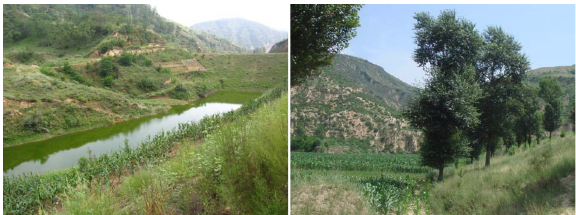
Fig. 1. Sample graphs of check dam (Left: Water body behind a check dam; Right: Farmland formed by a check dam) (Photo: Yafeng Wang and Yanda Xu)